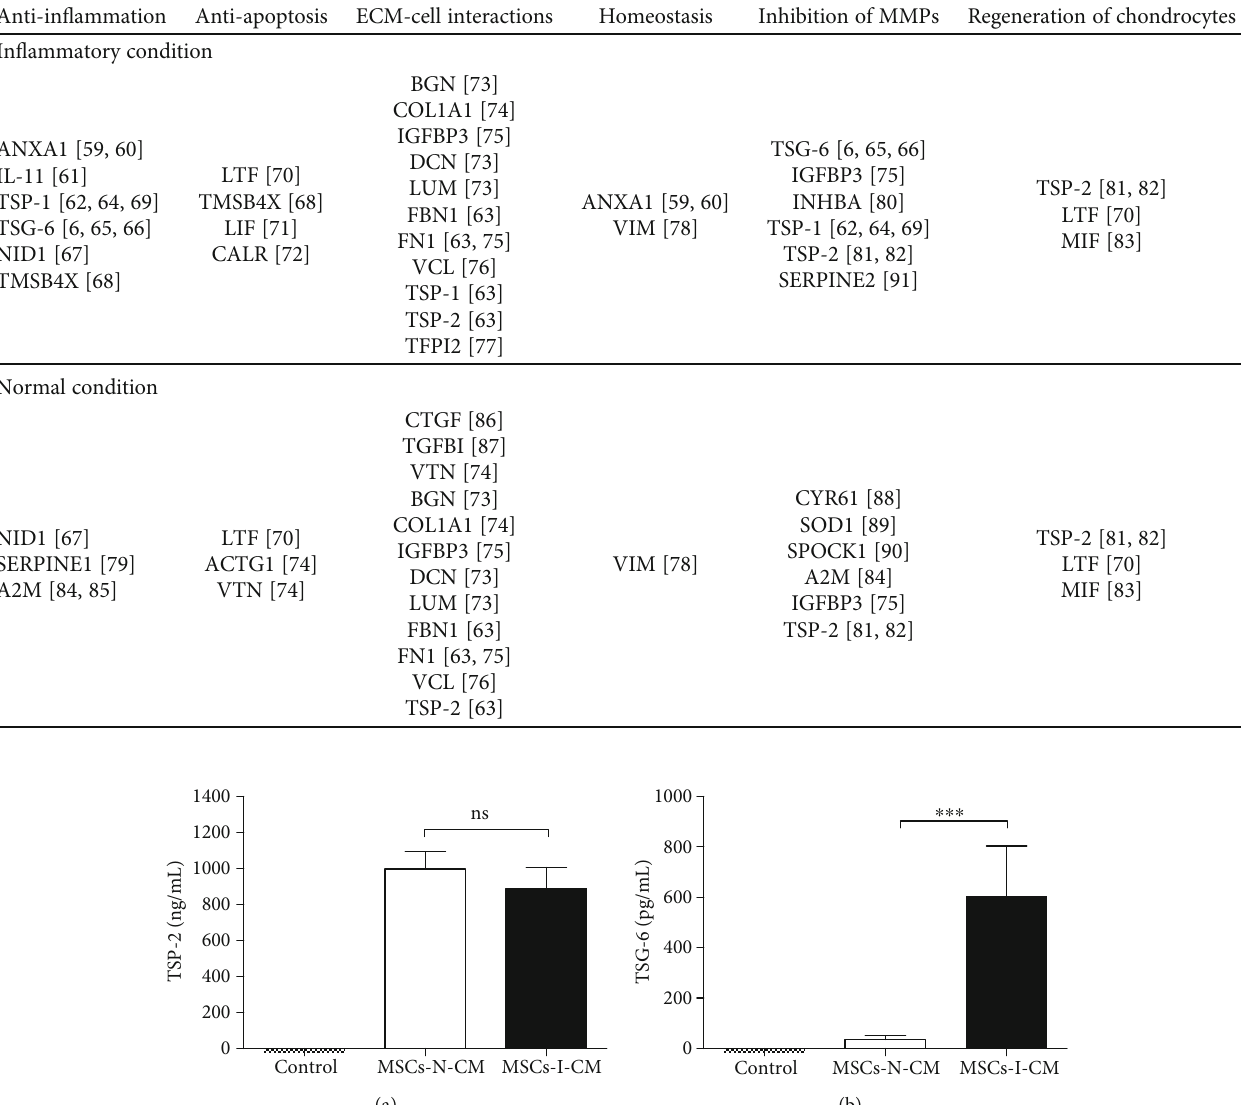
Table 2: The identi fi cation of proteins related to tissue regeneration.